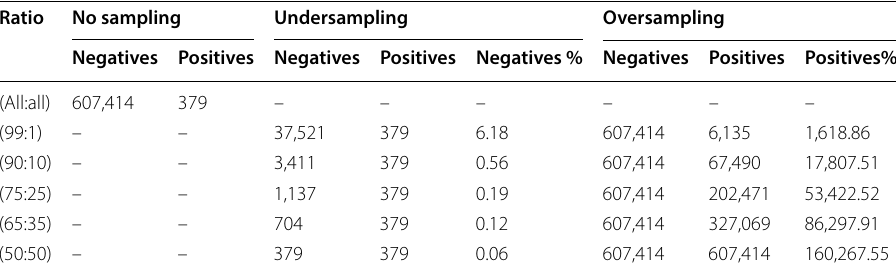
Table 1 Medicare sampling Ratio